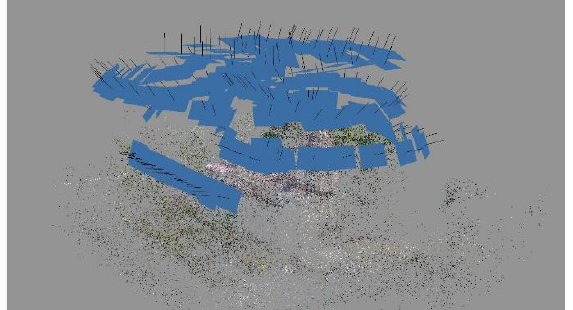
Figure 4. Scheme of UAV acquisition.